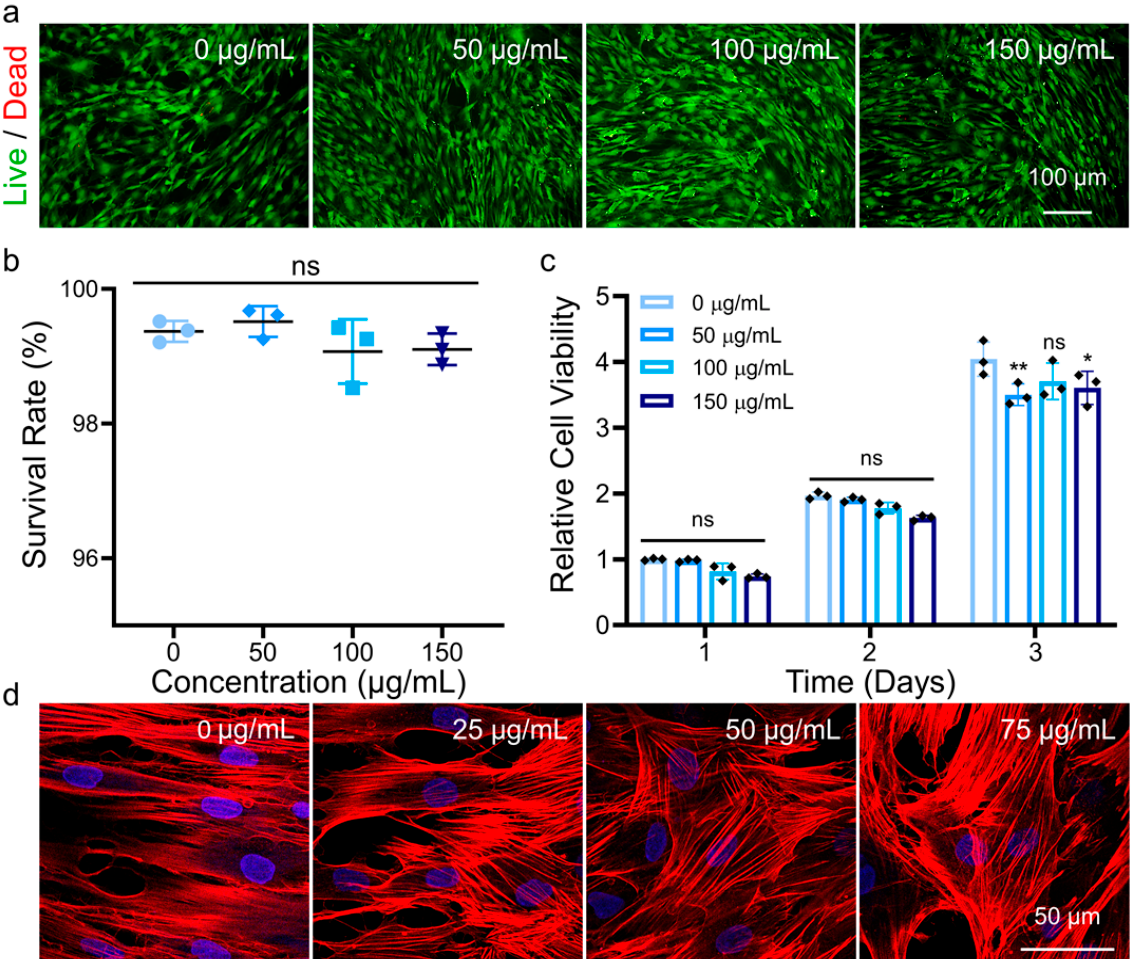
Figure 2. Viability and morphology of hADSCs cultured with MNPs. ( a ) Live/dead cellular staining images of hADSCs after culture with 0, 50, 100, and 150 μ g/mL MNPs for 3 days. The live cells were green, and the dead cells were red. ( b ) Survival rate of hADSCs cultured with increasing concentrations of MNPs for 3 days. Data represent mean ± standard deviation ( n = 3). Significance was determined by one-way ANOVA (ns: not significant vs. the 0 μ g/mL group). ( c ) Relative cell viability of hADSCs after incubation with 0, 50, 100, and 150 μ g/mL MNPs for 1, 2, and 3 days. Data represent mean ± standard deviation ( n = 3). Significance was determined by two-way ANOVA (* p < 0.05, ** p < 0.01, ns: not significant compared with the 0 μ g/mL group on Day 1). ( d ) Cytoskeleton staining images of hADSCs cultured with 0, 25, 50, and 75 μ g/mL MNPs for 3 days. F-actin was stained red, and nuclei were stained blue.